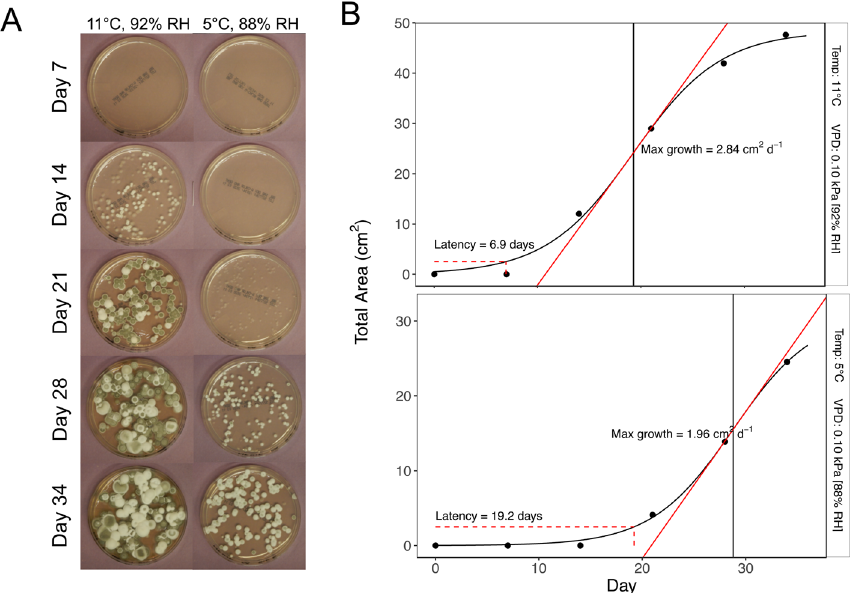
Figure 3. Examples demonstrate the process of measuring and estimating fungal growth of Pseudogymnoascus destructans ( Pd ) on media plates in temperature and humidity treatment conditions. ( A ) Examples of fungal growth on media plates measured at days 7, 14, 21, 28, and 34 from two of the treatment conditions (11 °C, 92% RH and 5 °C, 88% RH). ( B ) Examples of estimating maximum growth rate and latency variables from fungal growth measurements in panel A. We fit a sigmoidal curve to describe fungal growth (thick solid black line) to estimate the inflection point of the curve (vertical solid line). We calculated the slope (solid red line) at the inflection point of the curve to estimate maximum growth rate, and the days until total growth area reached 2.5 cm 2 (dashed red lines) as an estimate of